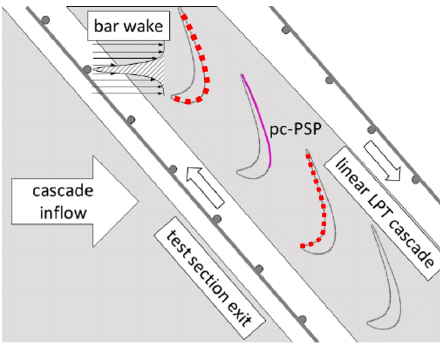
Figure 1. General arrangement of the HGK test section, see